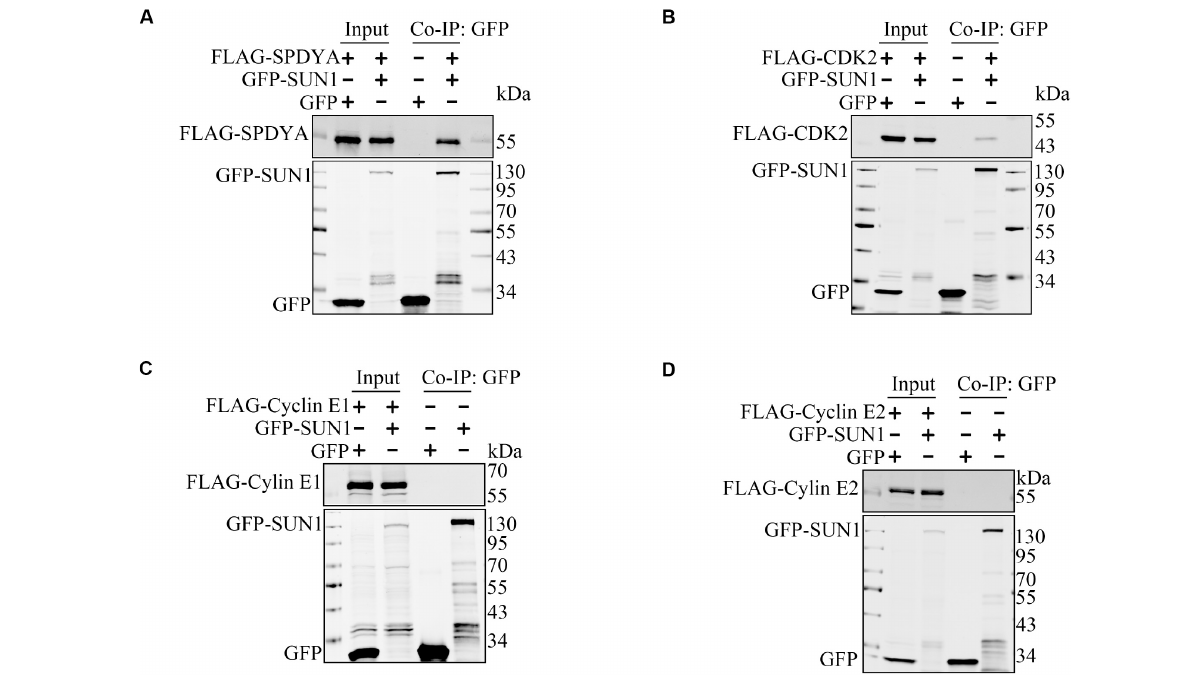
Frontiers in Cell and Developmental Biology |